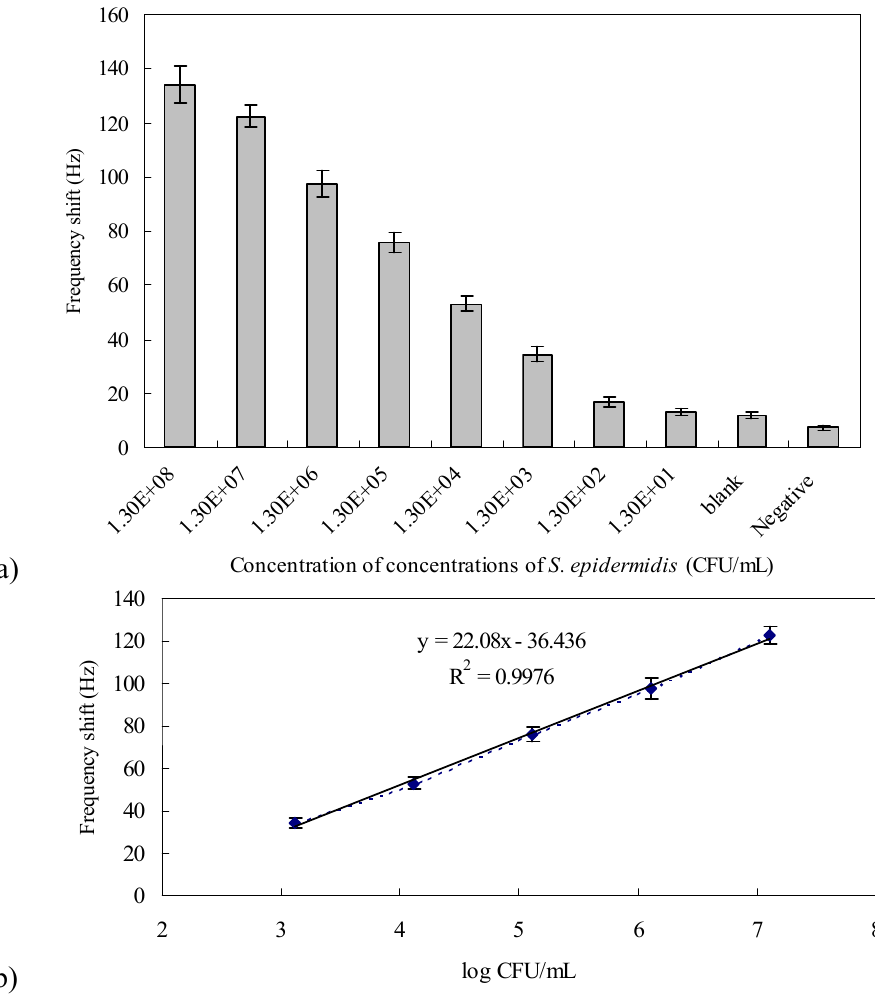
Figure 8. (a) The responses of the QCM sensor to the PCR-amplified DNAs isolated from different concentrations of S. epidermidis ; (b) A linear relationship between the frequency shift vs. log (CFU/mL of S. epidermidis ) was found from 1.3×10 3 to 1.3×10 7 CFU/mL. Error bars indicate the standard deviation